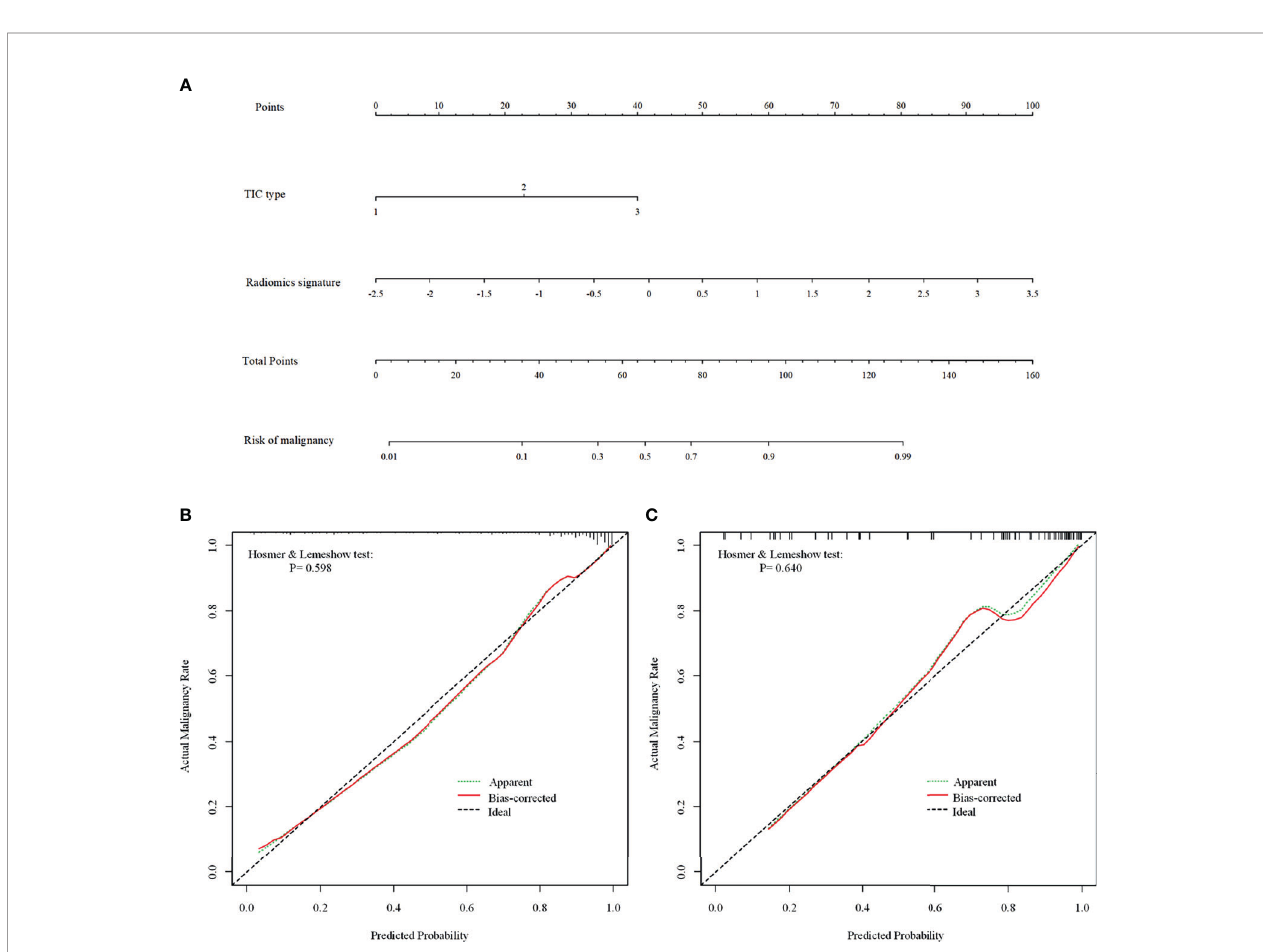
FIGURE 4 | The combined nomogram for differentiating benign and malignant non-mass enhancement (NME) lesions. (A) The radiomics nomogram developed with the training cohort included time-intensity curve (TIC) types and radiomics signatures. (B, C) Calibration curves of the combined model in the training (B) and validation (C) cohorts. The Bias-corrected line represents the nomogram performance. The closer the red Bias-corrected line is to the diagonal dotted (ideal) line indicates a better differentiation